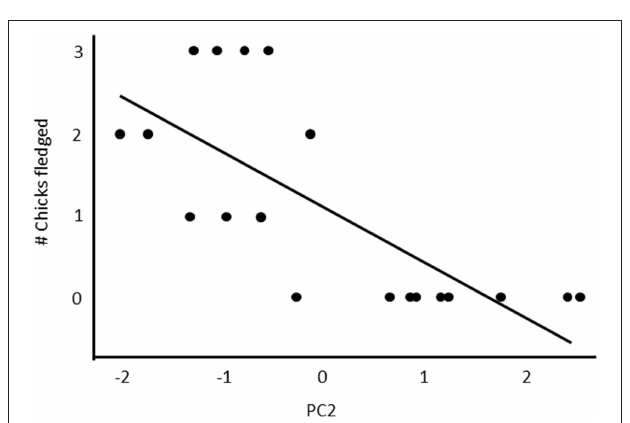
FIGURE 7 | The relationship between the PC2 scores of a PCA analysis and reproductive success. Table 2 indicates the loadings of each of the five song parameters on PC2.